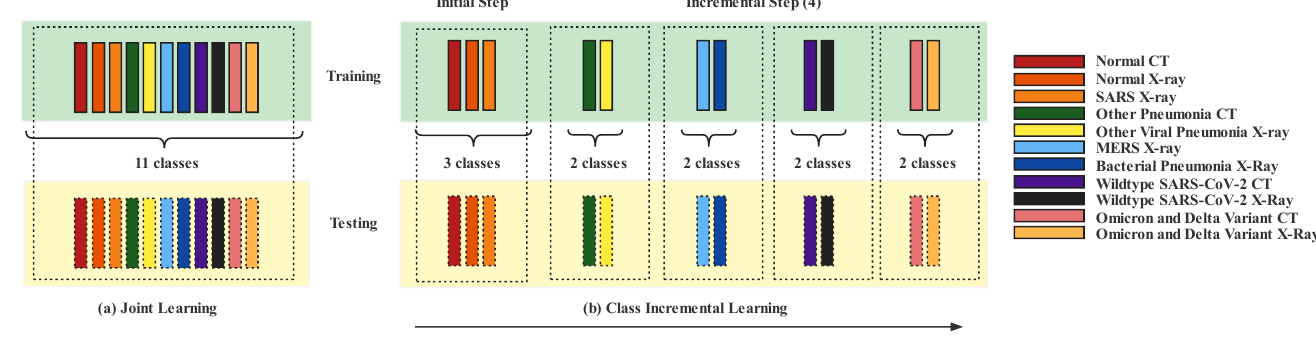
Figure 3. Using AI to simulate the discovery of coronaviruses: a contrast between joint and class- incremental learning experiments: ( a ) joint learning; ( b ) class-incremental learning experiment in which trials were conducted in five successive learning phases reflecting the actual epidemic timeline of different coronaviruses (namely, SARS, MERS, wild-type SARS-CoV-2, and the Omicron and Delta variants of SARS-CoV-2) in the real world.